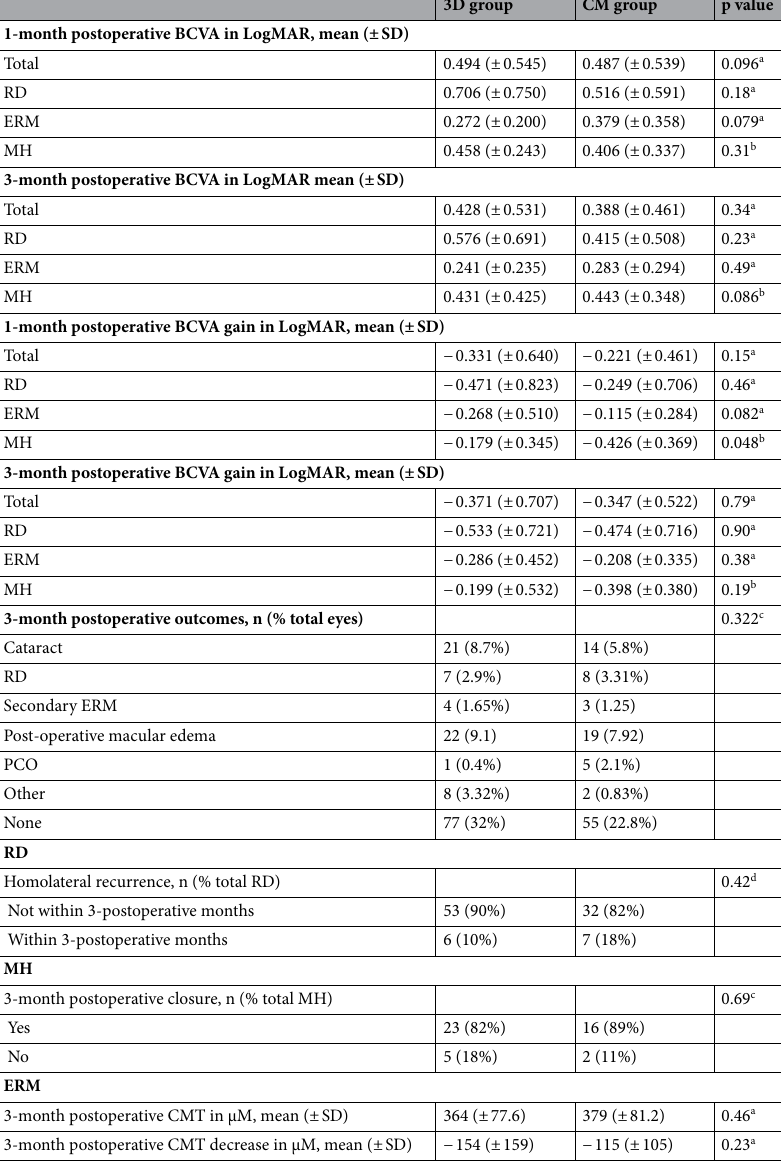
Table 4. Anatomical outcomes according to disease subgroup in the three-dimensional (3D) and conventional microscopy (CM) patient groups. CMT central macular thickness, ERM epiretinal membrane, LogMAR logarithm of the minimum angle of resolution, MH macular hole, PCO posterior capsular opacification, RD retinal detachment, SD standard deviation. a Welch’s t-test. b Mann–Whitney U test. c Fisher’s exact test. d Chi- squared